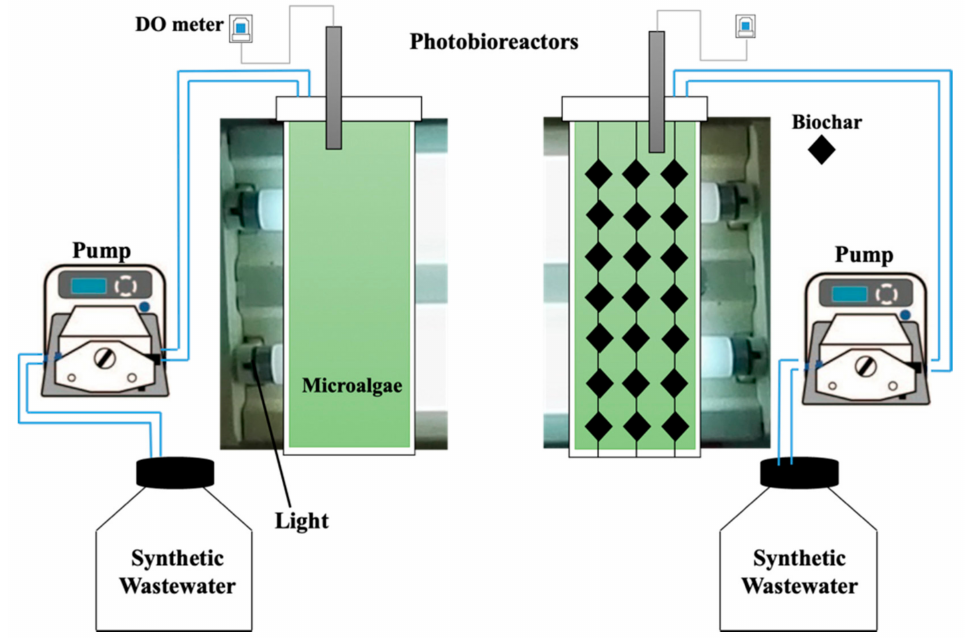
Figure 1. Schematics of the